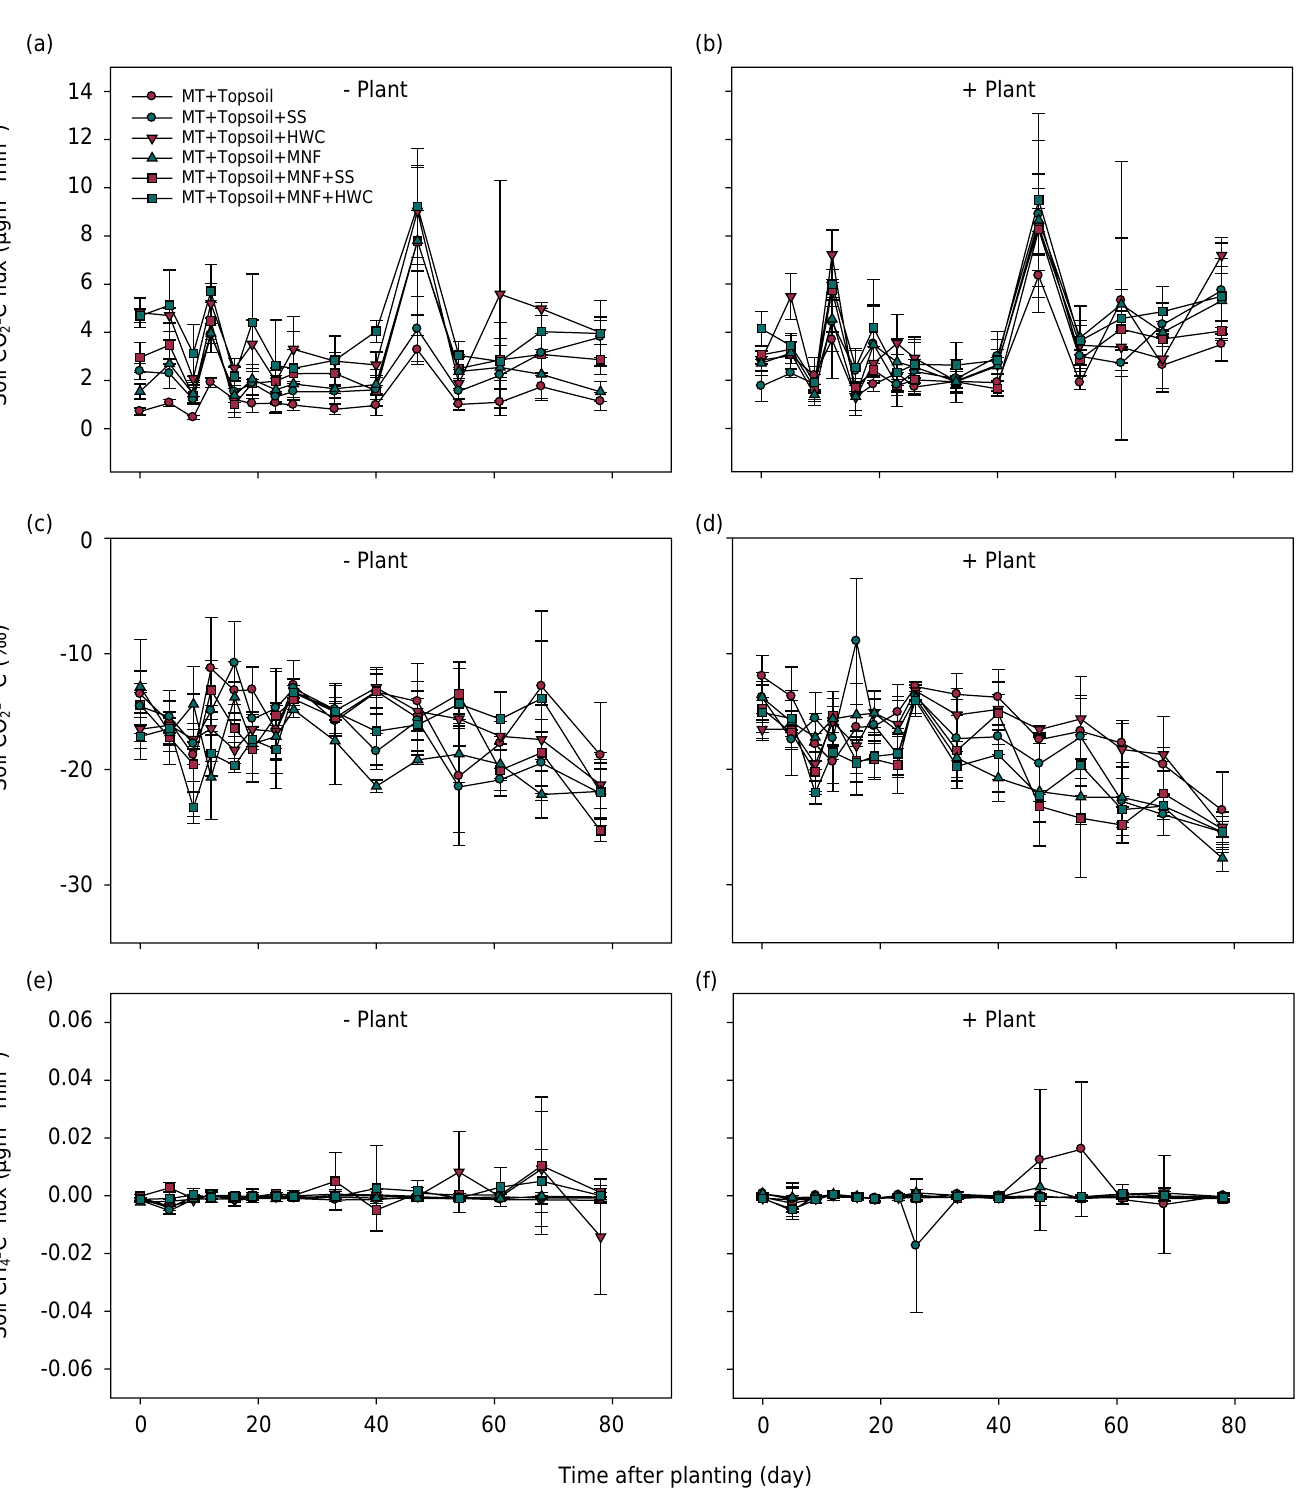
Figure 2. Soil CO 2 -C flux (μg m -2 min -1 ; a and b), Soil CO 2 - 13 C (‰; c and d), and Soil CH 4 -C flux (μg m -2 min -1 ; e and f) over the time (0, 5, 9, 12, 16, 19, 23, 26, 33, 40, 47, 54, 61, 68, and 78 days after sowing) in iron mining tailing + Topsoil (MT + Topsoil), without (-Plant) and with plant (+Plant), without (-MNF) and with mineral-N fertilization (+MNF) and different organic-N fertilization (non-organic-N fertilization, sewage sludge – SS, and household waste composting - HWC). Vertical bars are the means ± 90 % confidence interval (n =